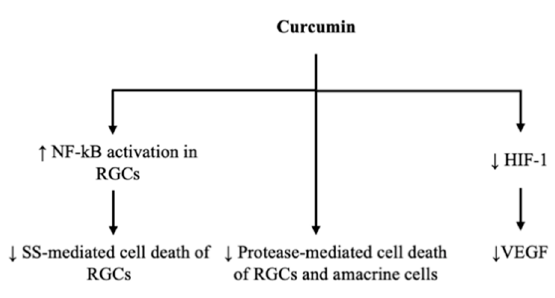
Figure 2. Schematic representation of molecular mechanisms leading to curcumin-mediated reduc- tions in glucose levels. Up arrow stands for augmentation, down arrow stands for reduction.